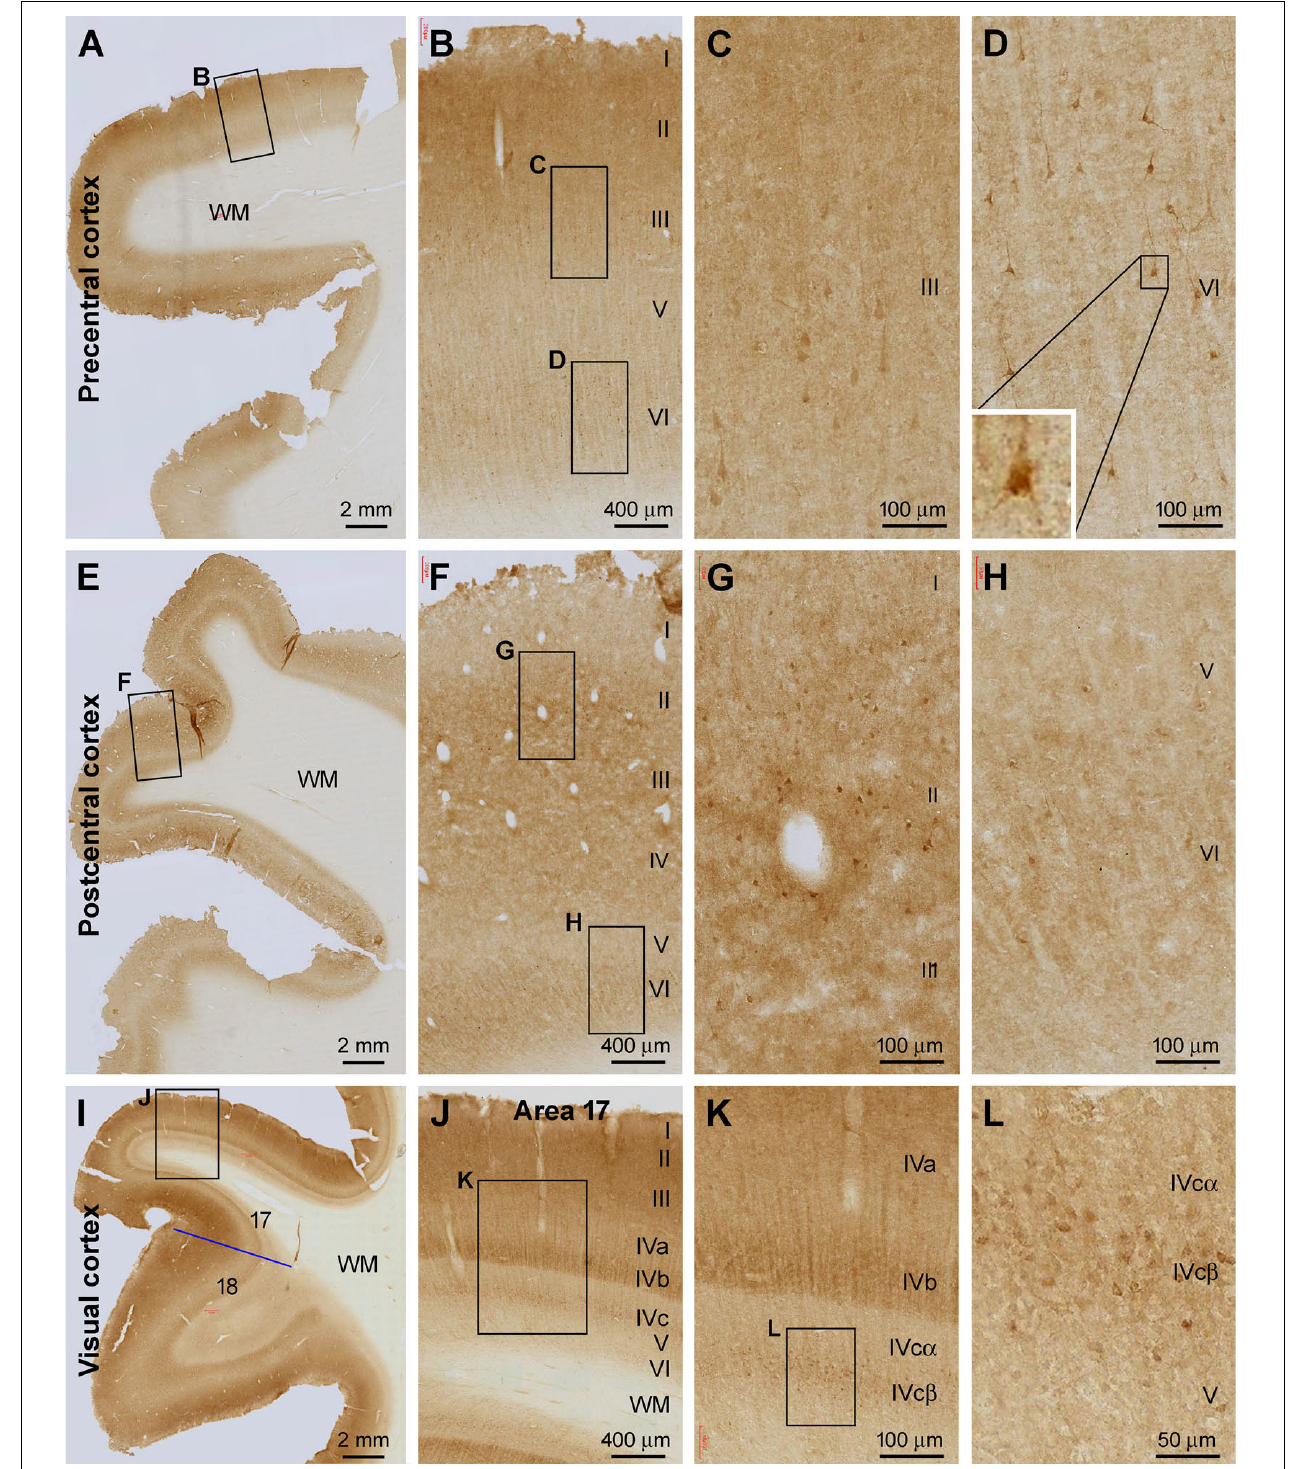
FIGURE 2 | Shank3 IR in the primary motor, somatosensory, and visual cortical areas. (A) shows low power view of the IR in the precentral cortex, with framed areas enlarged as (B–D) . (E) shows low magnification view of the IR in the postcentral cortex, with framed areas enlarged as (F–H) . (I–L) illustrate the IR in the primary (area 17) and secondary (area 18) visual cortical centers. The sublayers (IVa, IVb, IVc α , and IVc β ) of IV in area 17 exhibit differential intensity. A small group of neuronal somata, along with their apical and basal dendrites, shows moderate to strong IR; most of which appear pyramidal in shape. Scale bars are as indicated in the